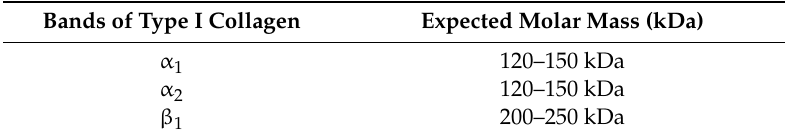
Table 5. Expected molar mass ranges for the peptides of collagen type I. The data for this table has been obtained from [35].